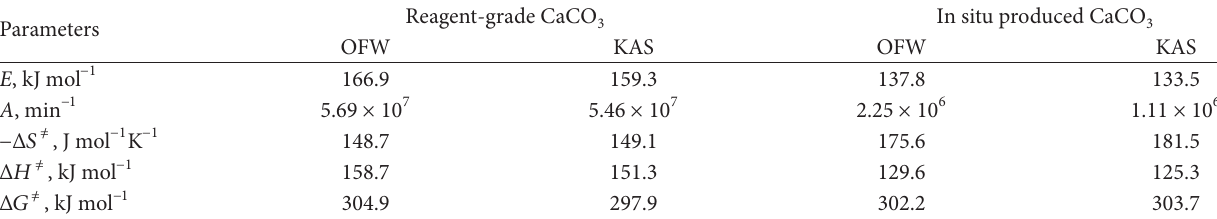
T 6: Kinetics parameters obtained with the most probable mechanism function g ( Sunose calculation